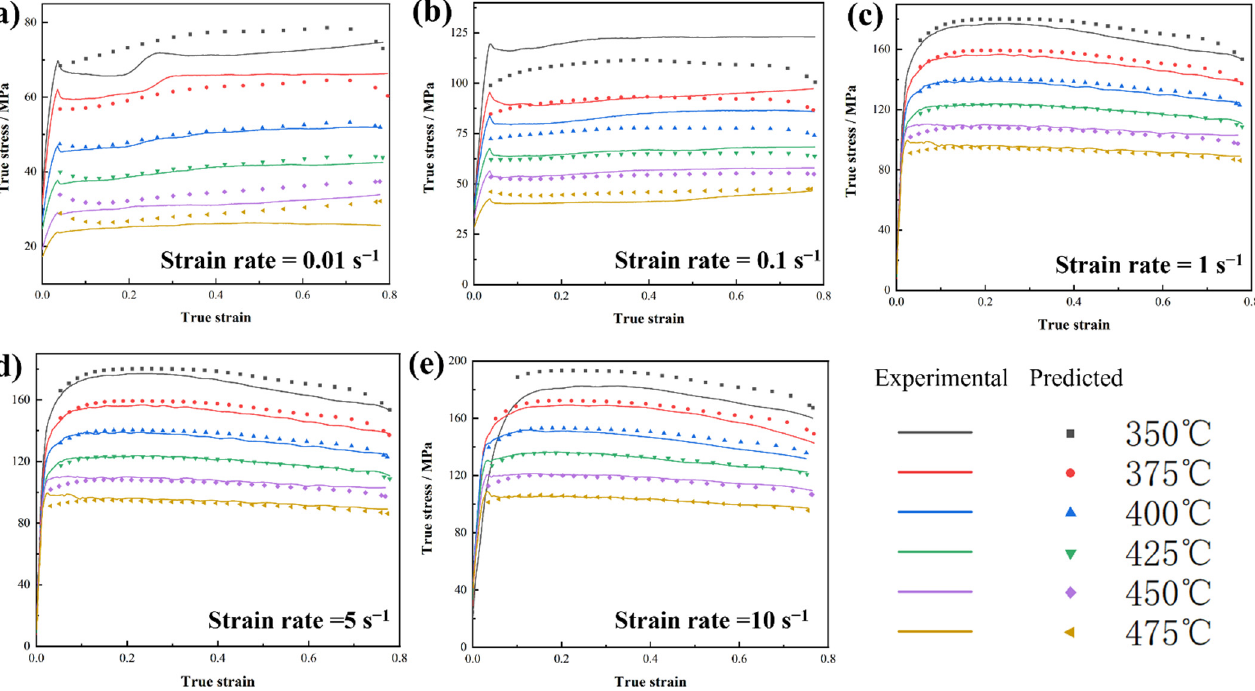
Figure 6. Prediction results of the AR model with various deformation parameters. ( a ) strain rate = 0.01 s − 1 ; ( b ) strain rate = 0.1 s − 1 ; ( c ) strain rate = 1 s − 1 ; ( d ) strain rate = 5 s − 1 ; ( e ) strain rate = 10 s − 1 .